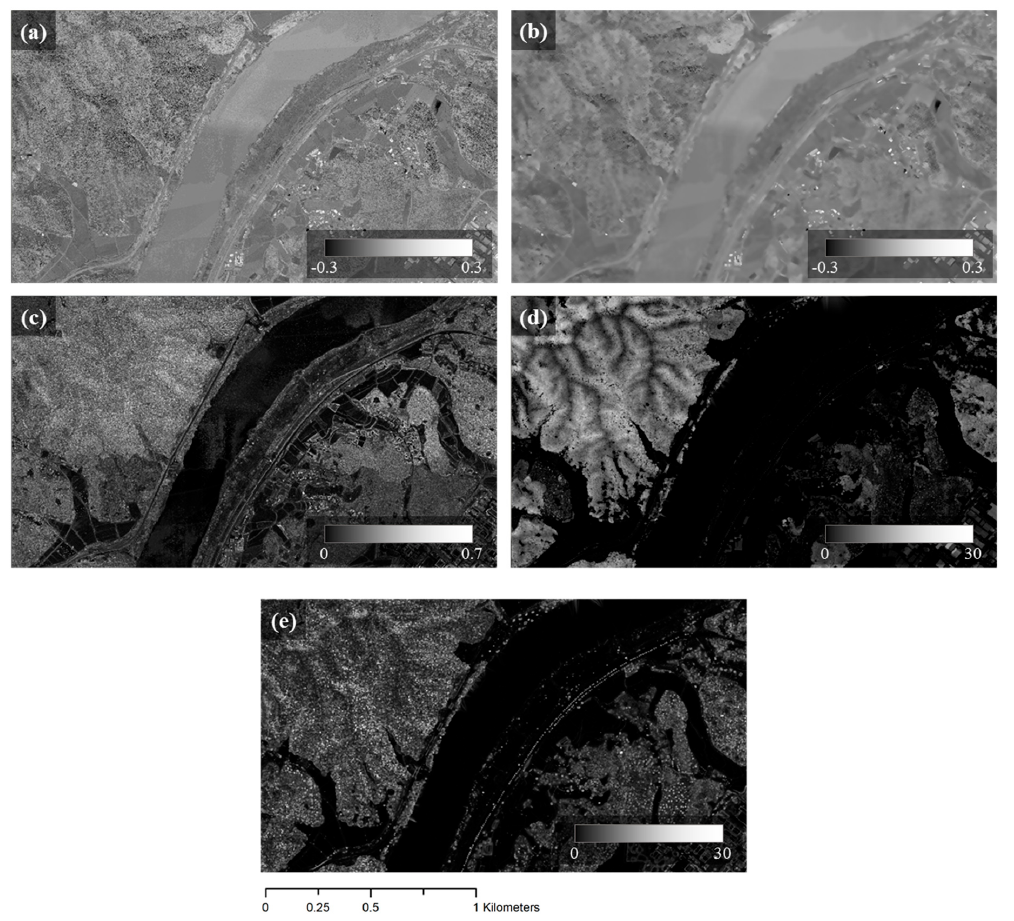
Figure 5. The five input layers used for the artificial neural network (ANN) analysis. ( a ) median-filtered index map; ( b ) non-local (NL)-means filtered index map; ( c ) reflectance texture map; ( d ) height difference map; and ( e ) height texture map.